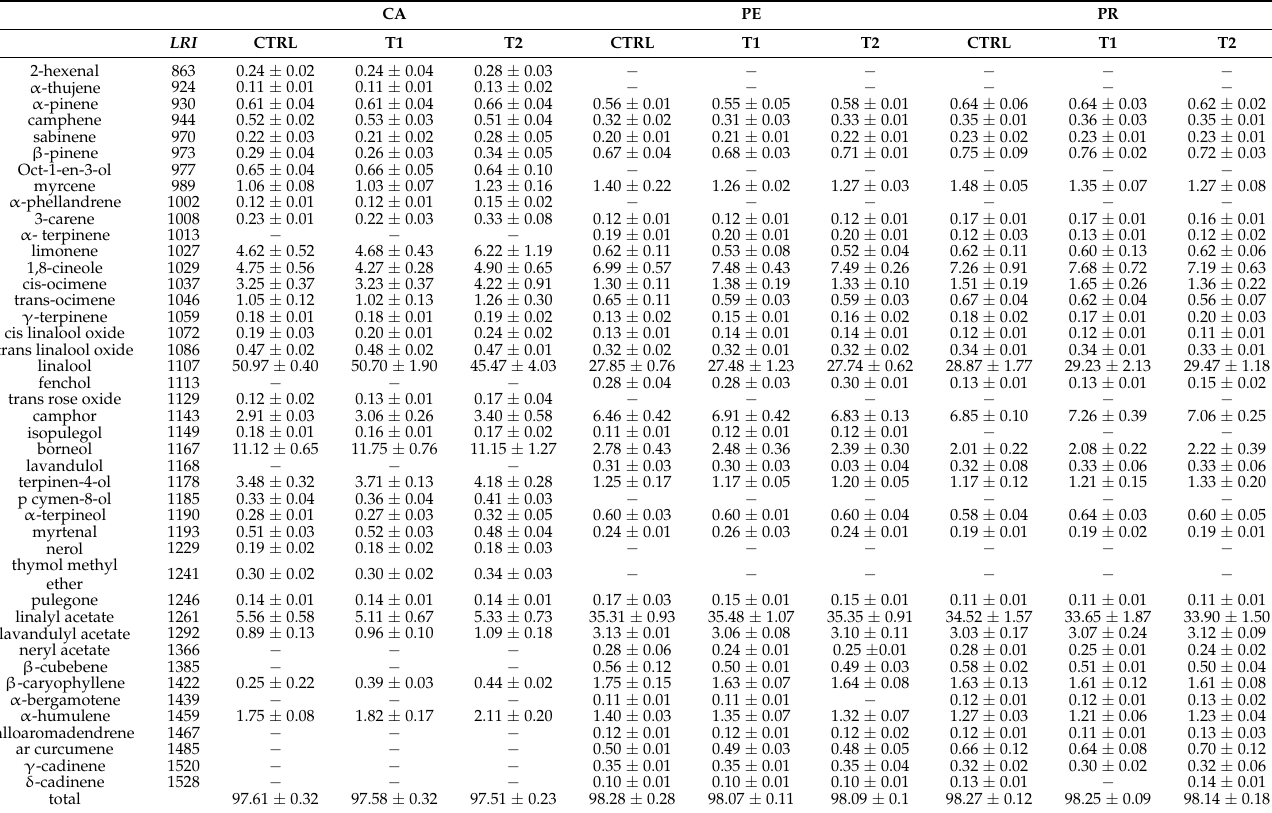
Table 4. Chemical composition % of the EOs expressed as mean ± standard deviation (n = 3). CA, Campazzo; PE, Pedroni; PR, Preci. CTRL, control with foliar application of tap water; T1, foliar application of FITOSTIM; T2, foliar application of FITOSTIM